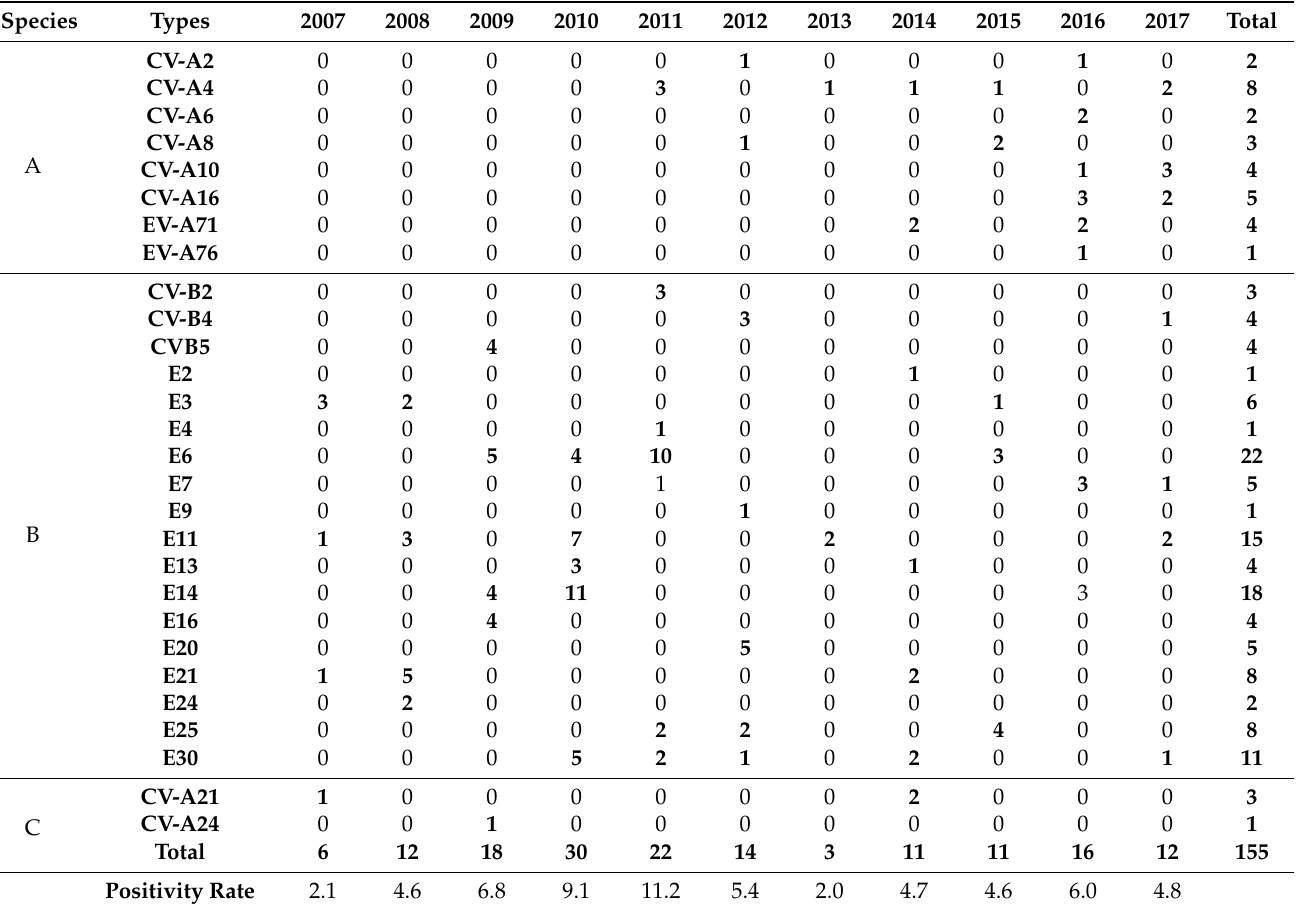
Table 2. Distribution of nonpolio enterovirus (NPEV) types identified per